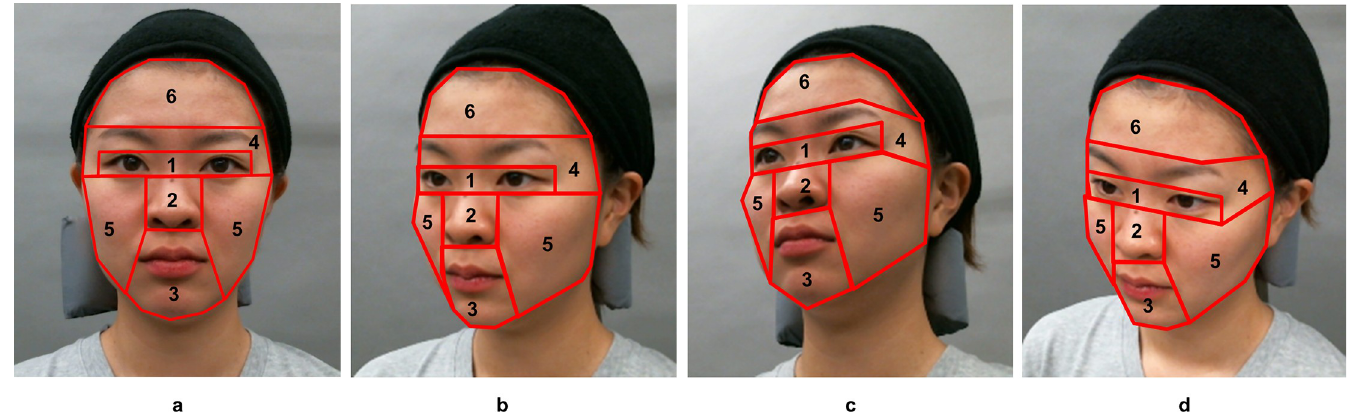
Fig 4. The regions of interest used for specifying the location for evaluating age. To specify the facial location used for evaluating age, six regions of interest (ROI) were selected: Eyes, nose, mouth, and the area surrounding the eyes, that is, eyebrows, cheek, and forehead in four directions: (a) 0˚ rotation (front), (b) 45˚ rotated right in the yaw (right side), (c) 33˚ rotated right in the yaw and pitch above (right upward), and (d) 33˚ rotated right in the yaw and pitch below (right downward).